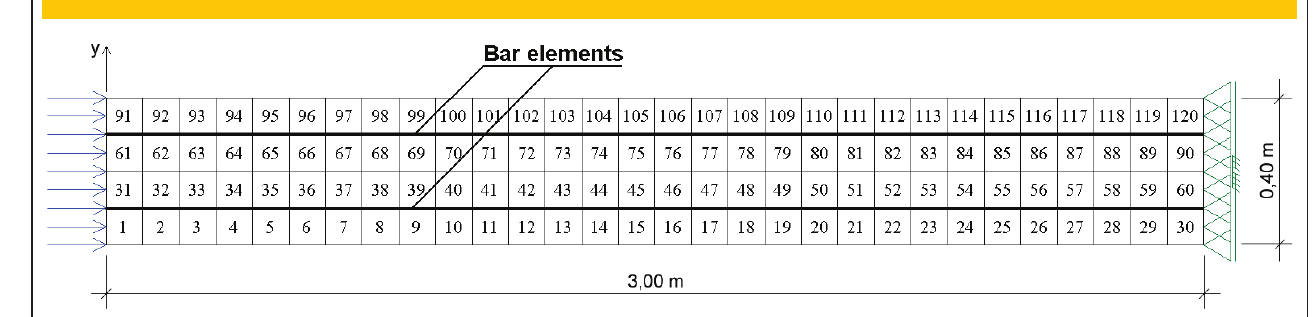
Figure 5 – Problem domain and finite element